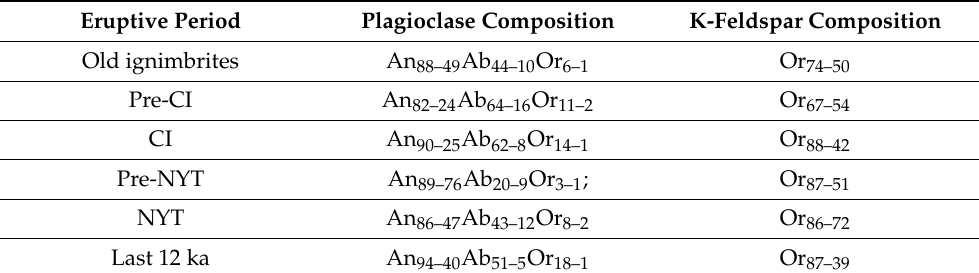
Figure 6. ( a – c ) An-Ab-Or classification diagram of feldspars; ( d ) An (mol %) and ( e ) Or (mol %) frequency histograms showing the distribution of Campi Flegrei feldspar composition. Table 2. Plagioclase and K-feldspar composition of products emplaced during different Campi Flegrei periods of activity. An = anorthite; Ab = albite; Or =